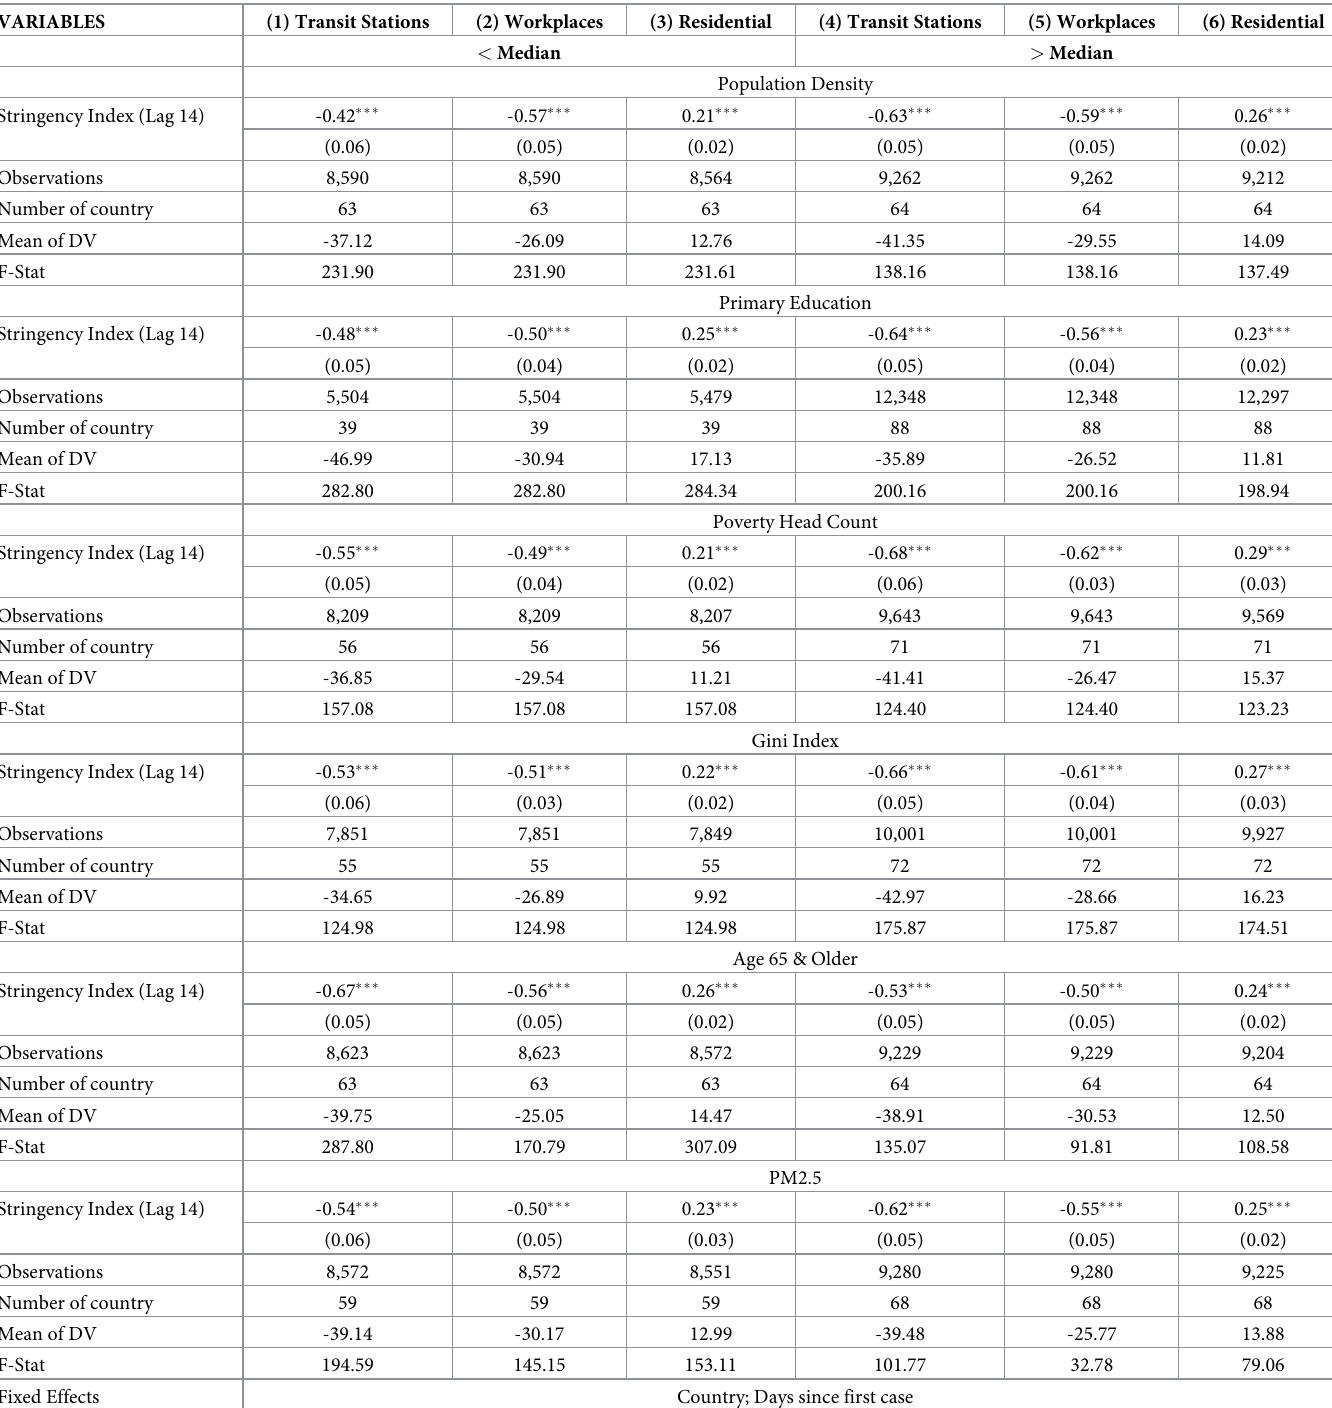
Table 4. Heterogenous impact of stricter restrictions on mobility